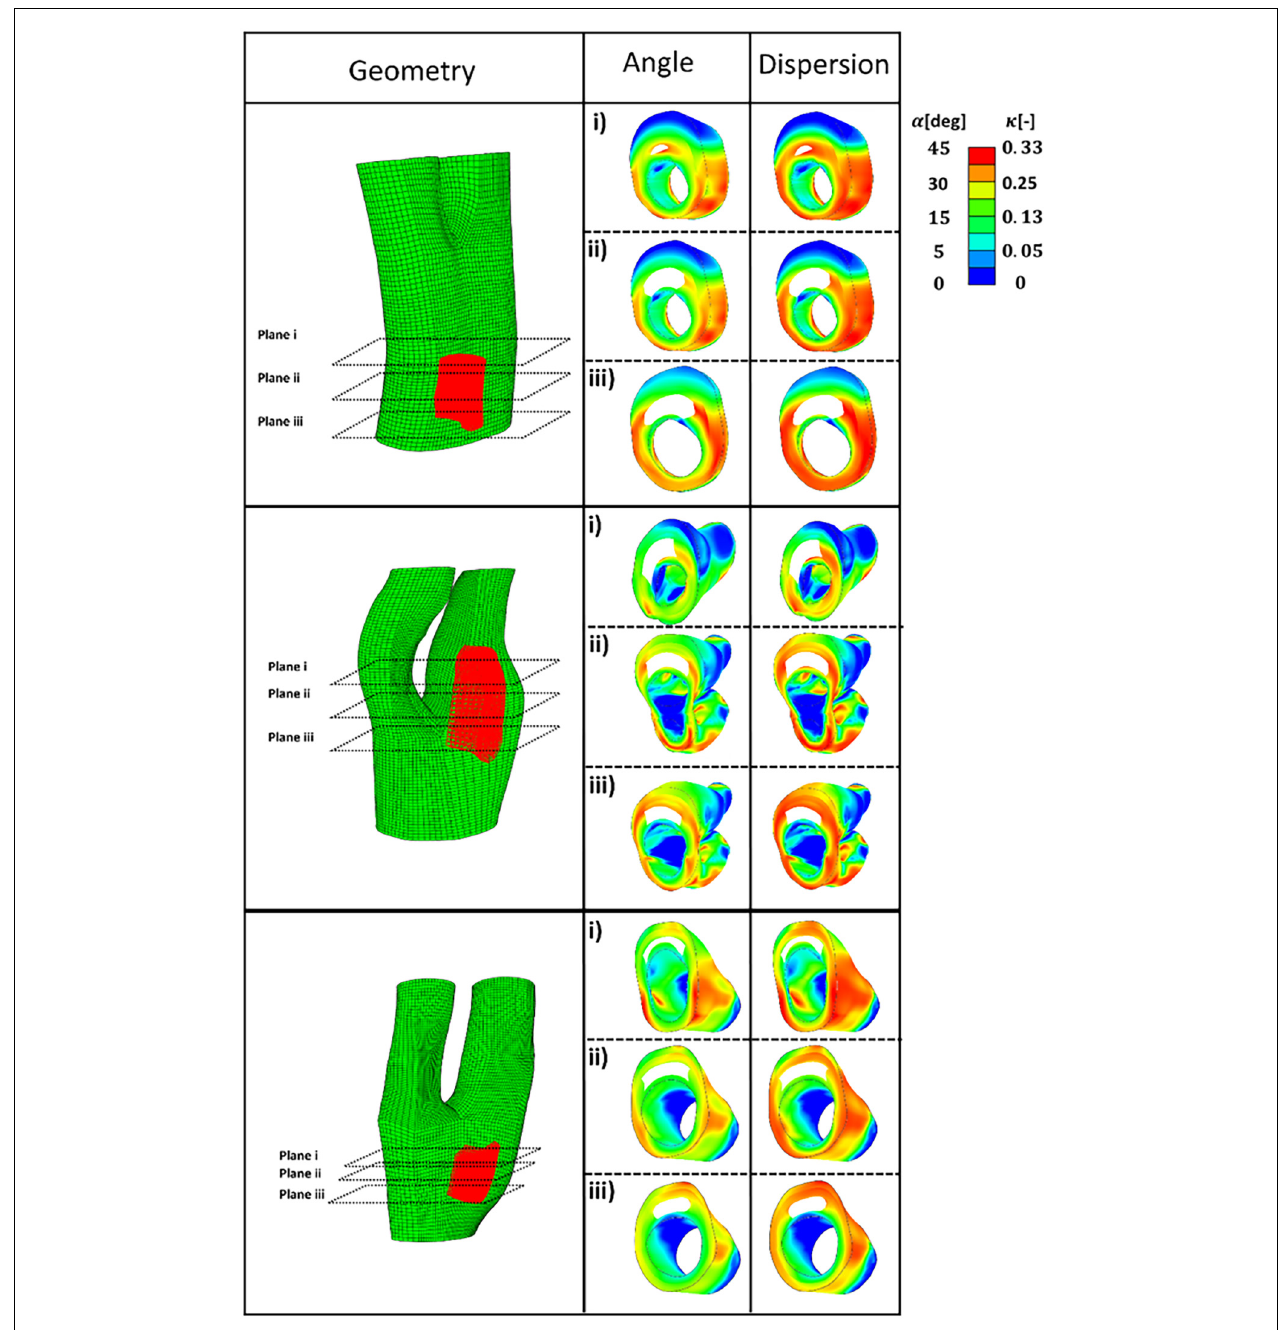
FIGURE 9 | The predicted angle and dispersion of fibres in three cross-sections of diseased bifurcations where a lipid pool was observed in the